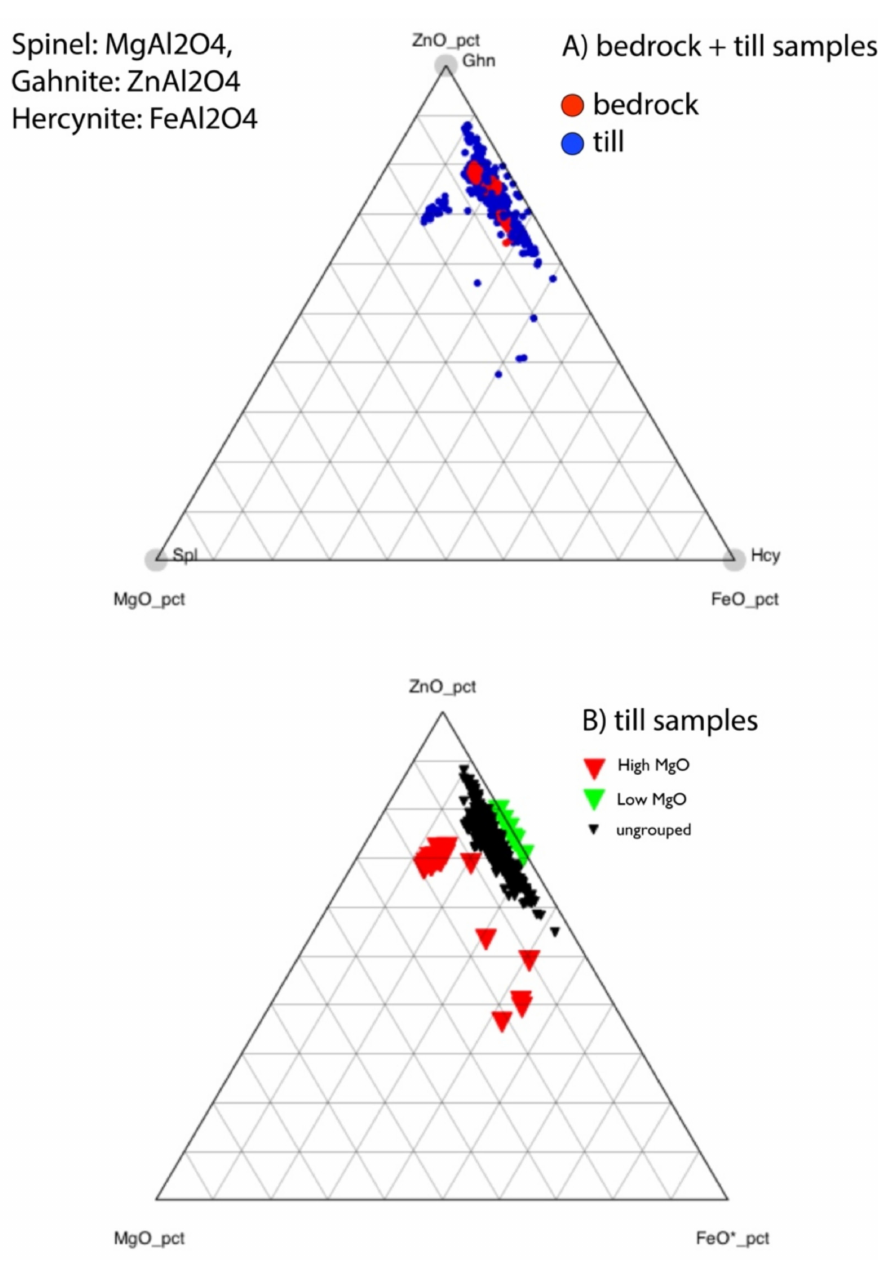
Figure 9. Ternary plot of zincian spinel compositional in terms of gahnite, spinel and hercynite end members for: ( A ) bedrock from Izok Lake deposit, and ( B ) till samples down ice of the Izok Lake